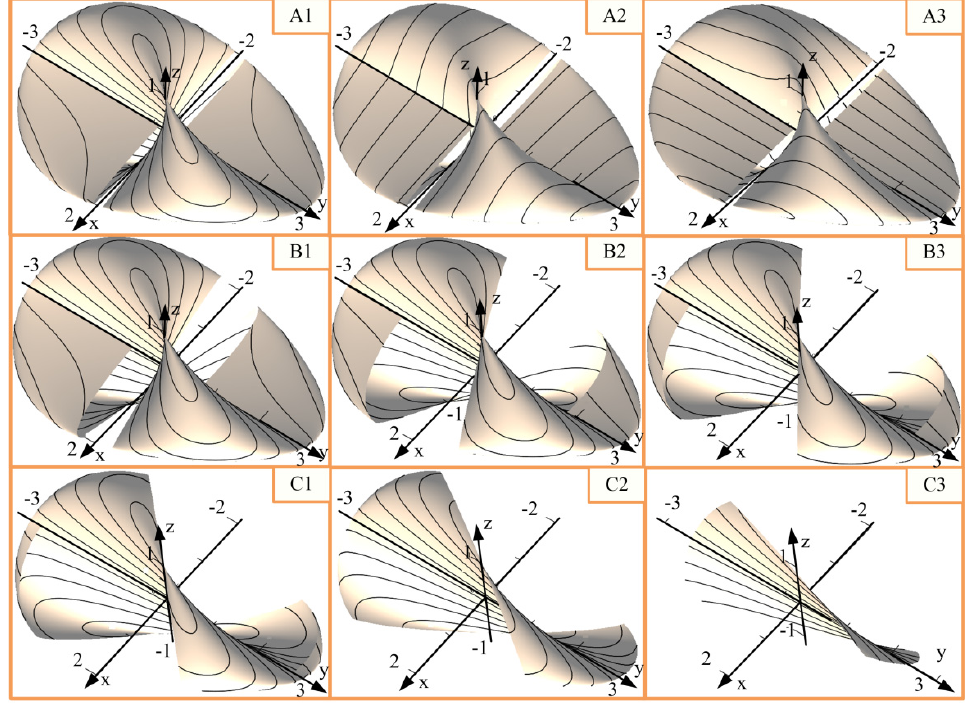
⊥ S . , ] d d − . The surface S ⊥ grows up